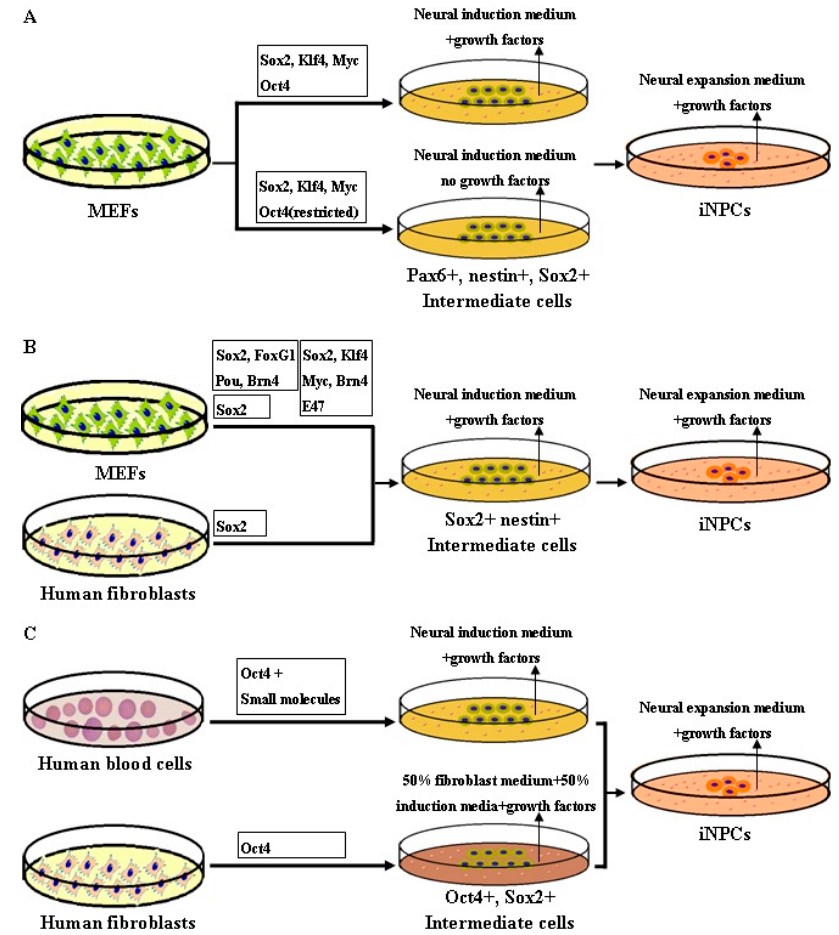
Figure 3. ( A ) A schematic diagram showing iNPC reprogramming from mouse embryonic